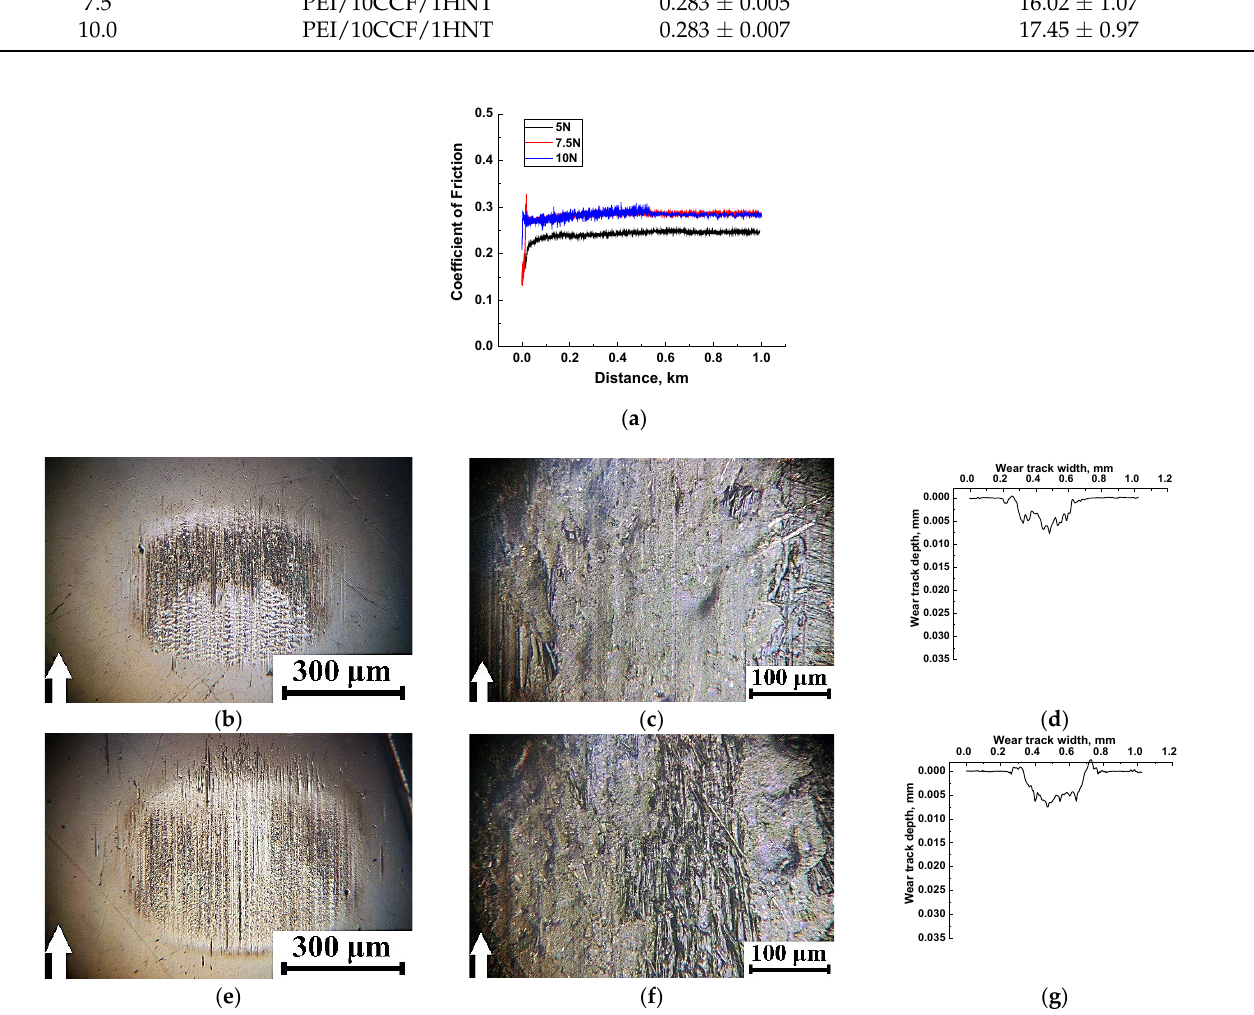
Figure 15. The time dependence of CoF values for the PEI/10CCF/1HNT nanocomposite in the tribological tests at the loads of 5, 7.5 and 10 N and a sliding speed of 0.3 m/s ( a ). Optical micrographs of the steel counterpart surface ( b , e ), wear tracks ( c , f ) and their profiles ( d , g ). Loads were 7.5 ( b – d ) and 10 N ( e – g ). Point tribological contact.